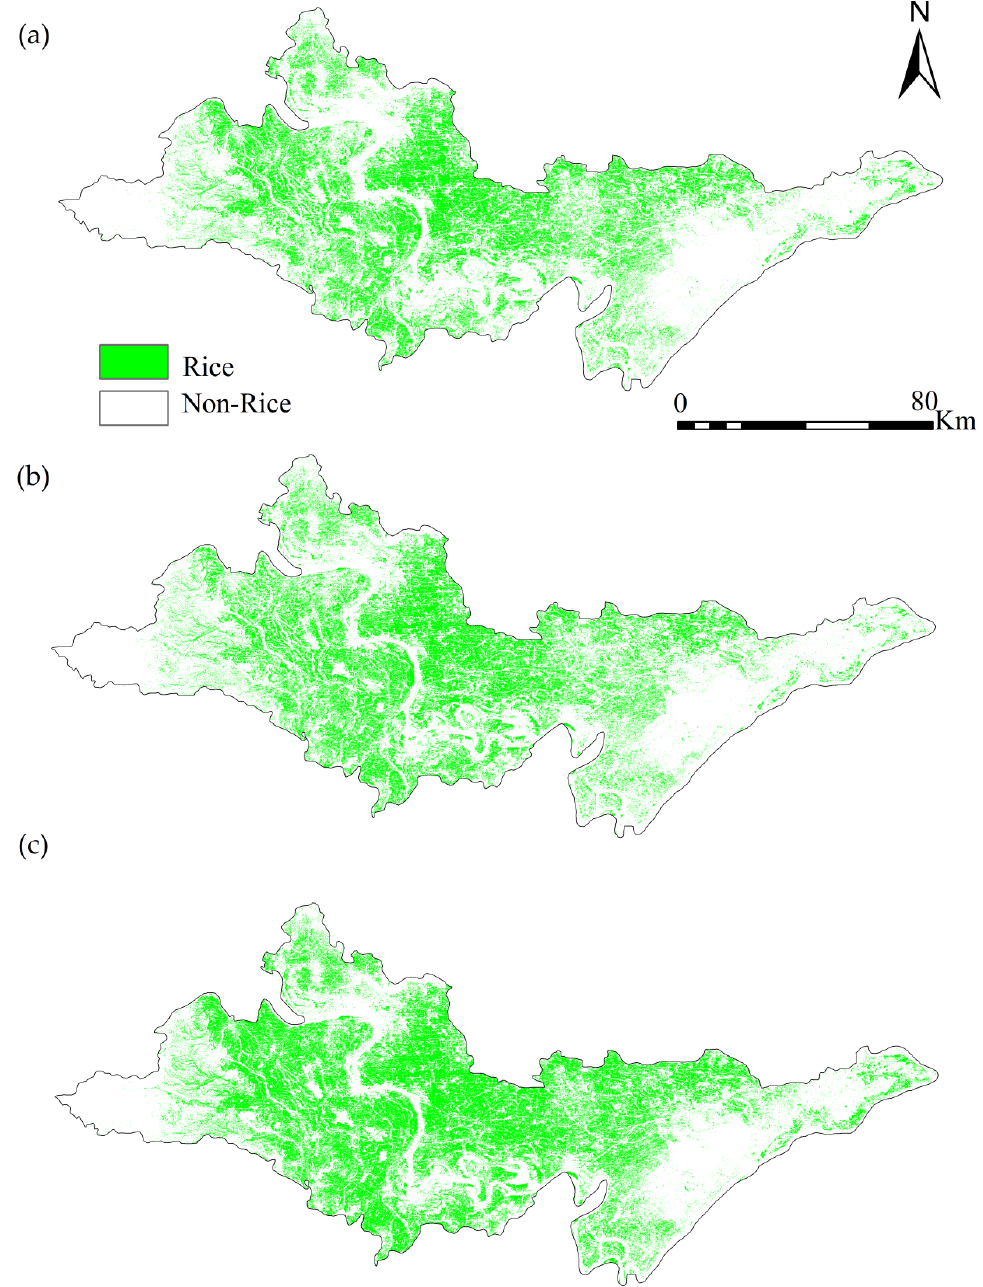
Figure 10. The rice mapping of Jingzhou City (( a ) REDT method based on GF-6 rice map; ( b ) NNE method based on GF-6 rice map; ( c )-NNE method based on GF-1 rice map).